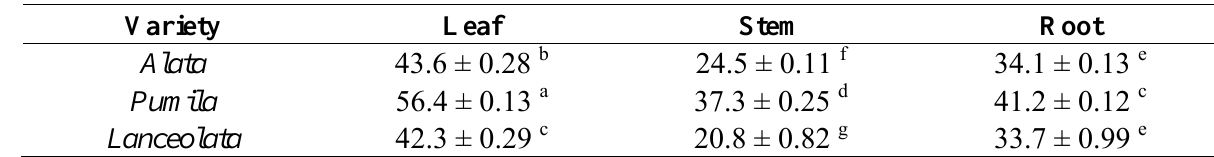
Values are means of three replications; means with the different letters are significantly